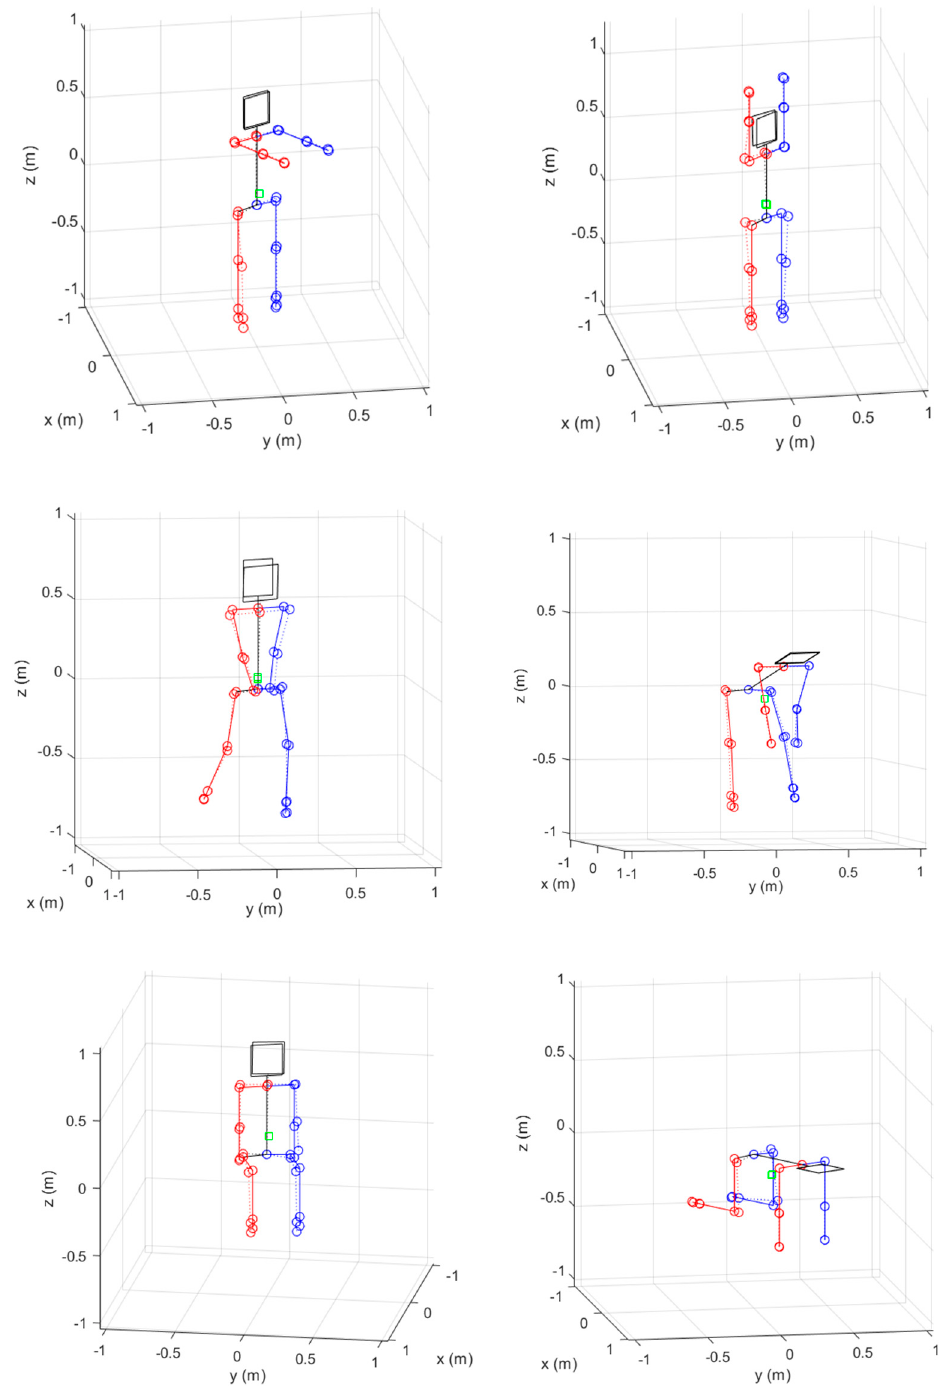
Figure 10. Pose estimation results for the six representative poses generated by the humanoid model (solid line: true pose, dotted line: estimated pose, red line: right parts, blue line: left parts).